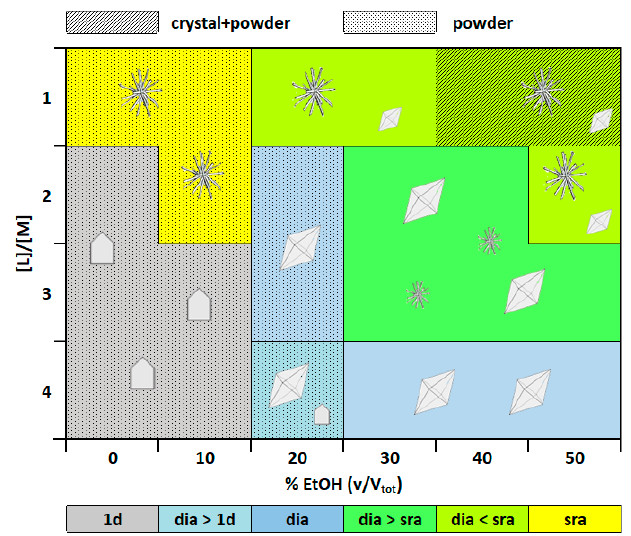
Figure 2. Equilibrium phase diagram for aqueous EtOH solutions of CdCl 2 -bpp system at a 20 mM total concentration of the reactants, with indication of the stability regions for 3D- sra , 3D- dia and 1D- cha species as a function of [L]/[M] molar ratio and the solvent composition (M = Cd 2+ , L = bpp).